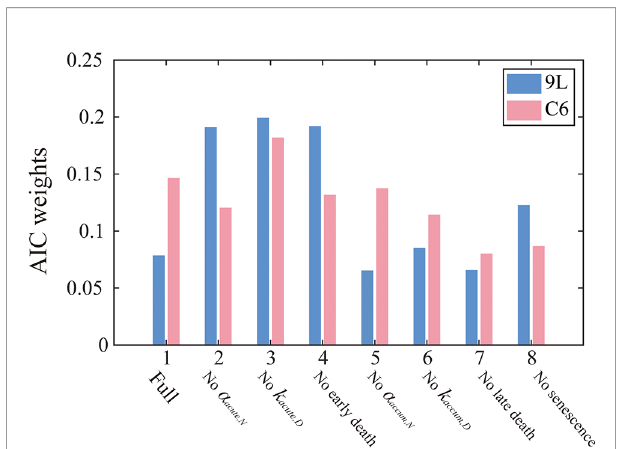
FIGURE 4 | AIC weights for each model models. The label, “ Full ” on the horizontal axis indicates that all model components are included [i.e., Eq. (1) – (10)], while the other labels indicate what portion of the Full model was removed in that particular reduced model. AIC weights can be interpreted as the probability that a particular model is preferred for modeling the 9L (blue) or C6 (red) cell line. In particular, Model 3 is most frequently selected by the AIC for both the 9L and C6 cell lines. Models without accumulation effects (i.e., model 5-8) generally perform worse than models without early effects (model 2-4), indicating the importance of incorporating the effects of late cell killing over acute